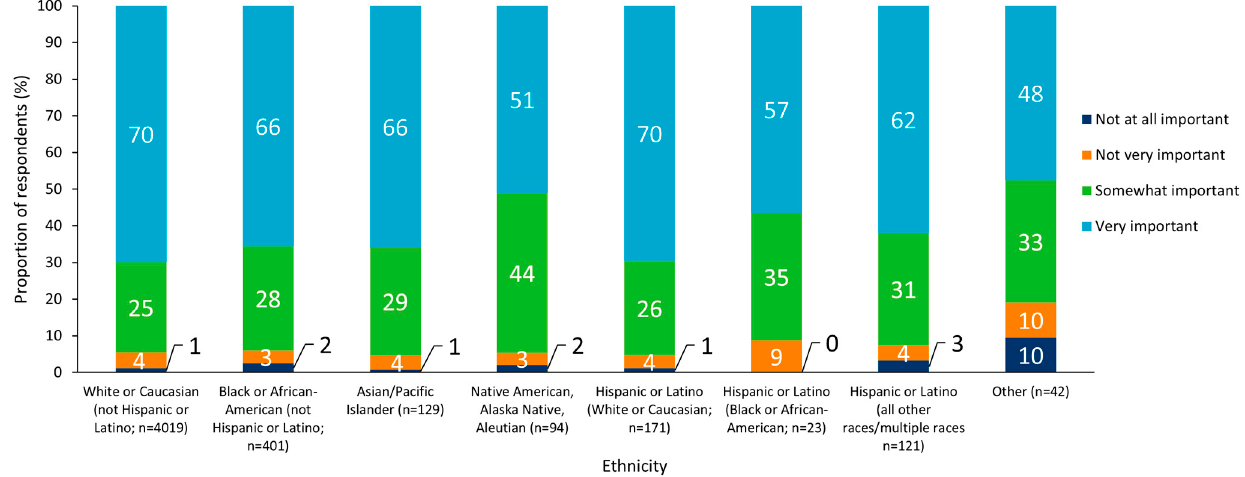
Figure 4. Perceived importance of state vaccination programs split by respondent ethnicity.